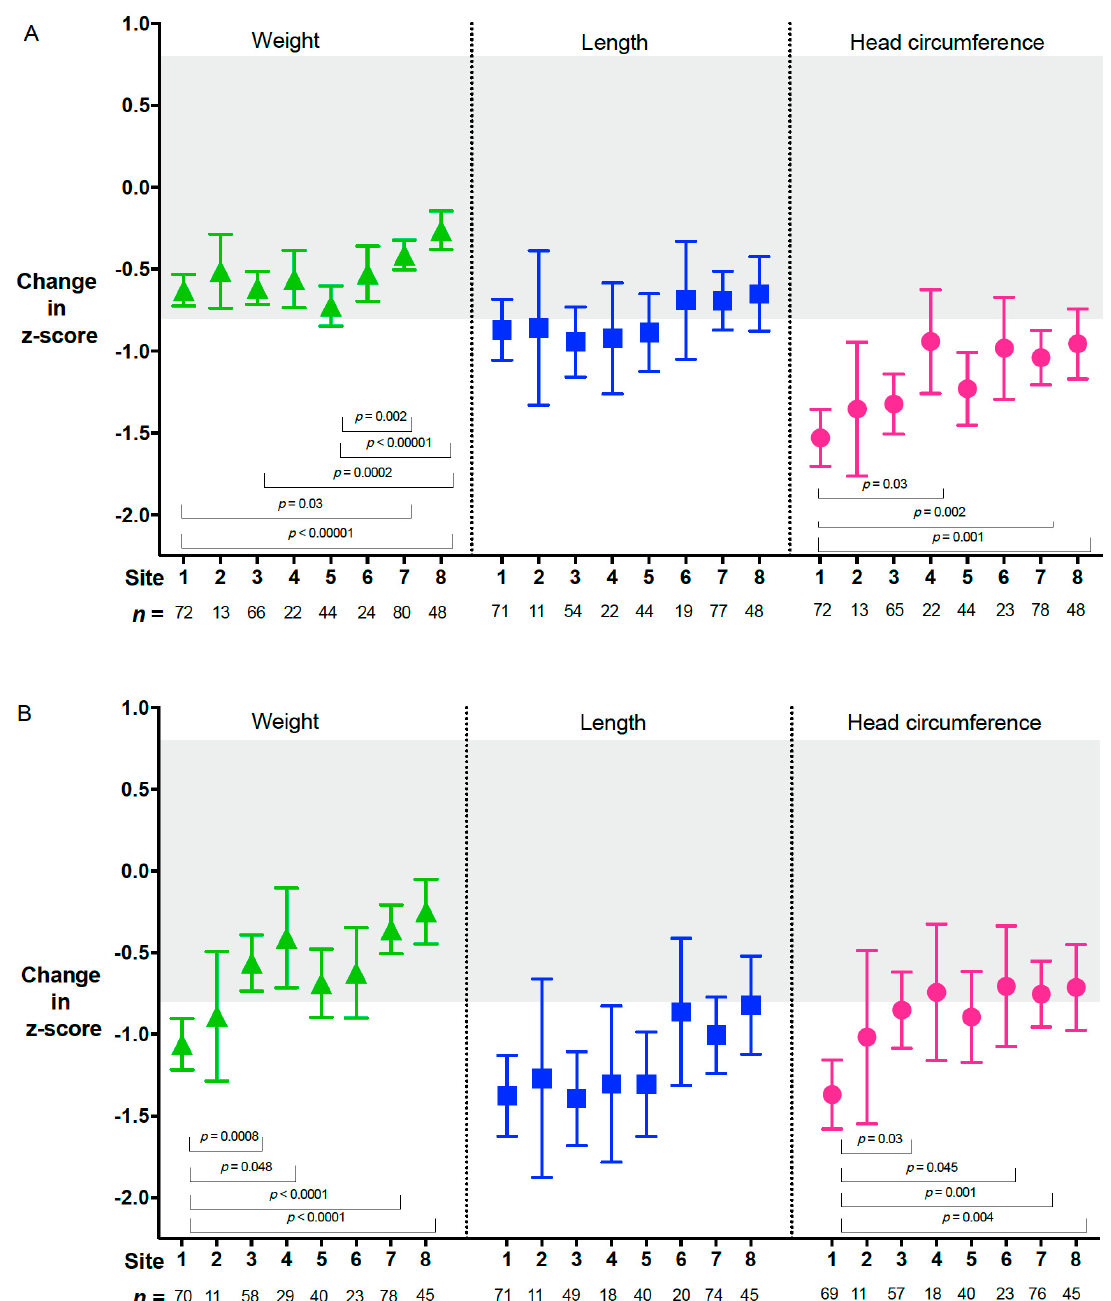
Figure 4. Change in z-score from birth for each site. Change in z-score from birth to 4 weeks ( A ) and 36 weeks’ corrected age ( B ) for each site, adjusted for site, sex, gestational age at birth and birthweight z-score. Data are median and interquartile range. Expected growth (z-score change > − 0.8 to < 0.8) is indicated by the grey shaded area. CA, corrected age.